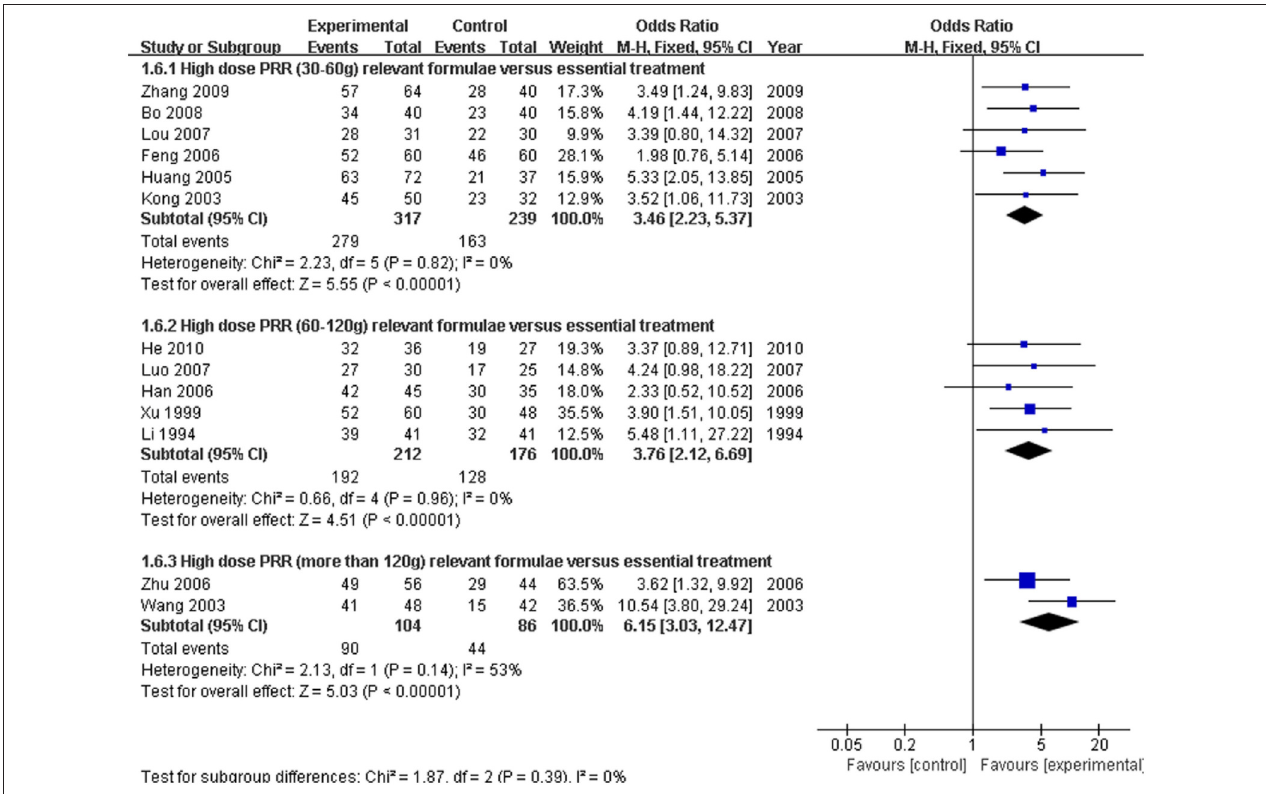
FIGURE 9 | Forest plot of the different ranges of high-dose PRR-relevant formulae combined with essential treatment vs. essential treatment alone. (1) Study item displayed as the first author with the publication year. (2) Subgroups were classified as PRR 30–60 g, PRR 60–120 g and PRR greater than 120 g. (3) I-squared and P are the criterion of the heterogeneity test, (cid:7) pooled odds ratio, — (cid:4) — odds ratio, and 95% confidence interval.